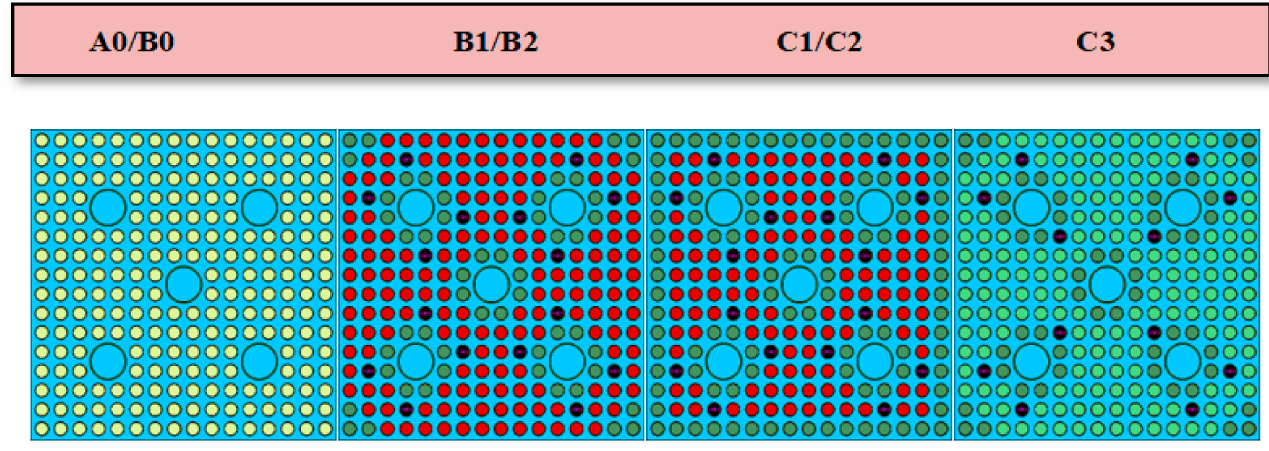
Figure 4. APR-1400 fuel assemblies cross sectional